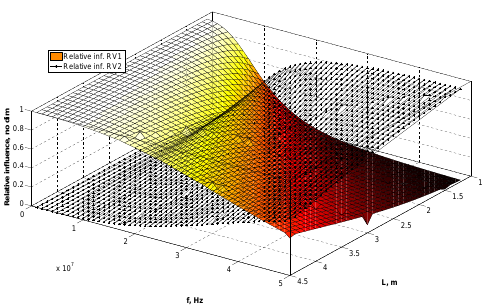
Figure 14: Relative influence of L / f parameter from one to